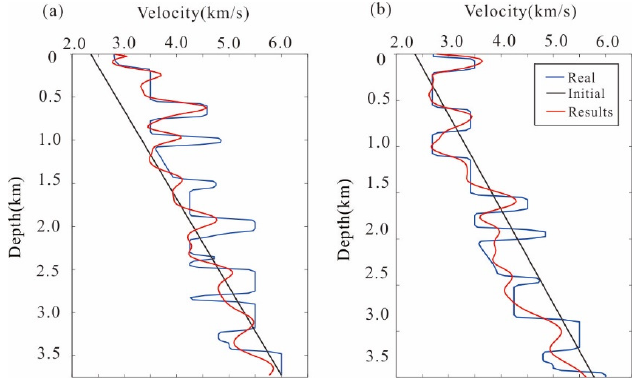
Figure 6. Schematic showing the depth − velocity profiles at positions of 5 km ( a ) and 10 km ( b ) of the overthrust velocity model. The blue, black, and red represent real, initial, and inversion results, respectively.